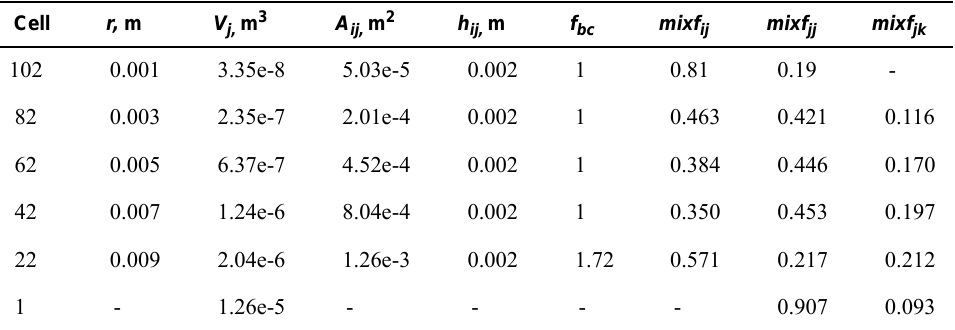
Table 36. Mixing factors for finite difference calculation of diffusion in spheres. [-, undefined value for